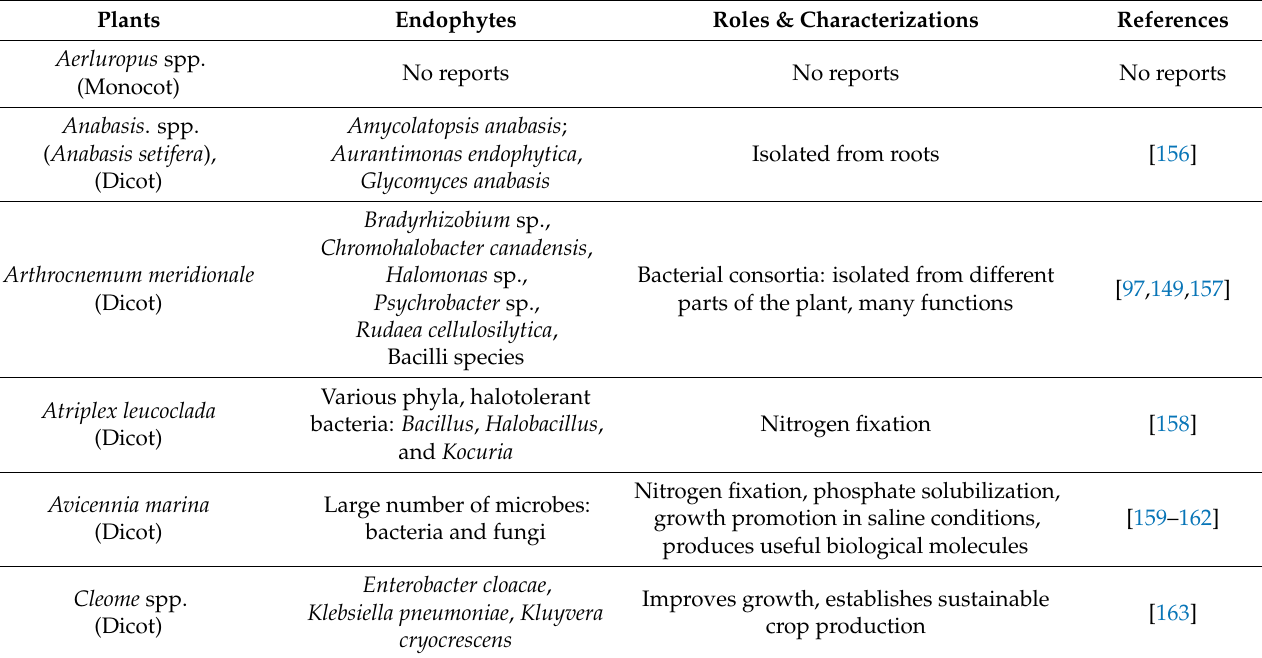
Table 4. Possible endophytic bacteria associated with halophyte plants playing various roles in the flora of